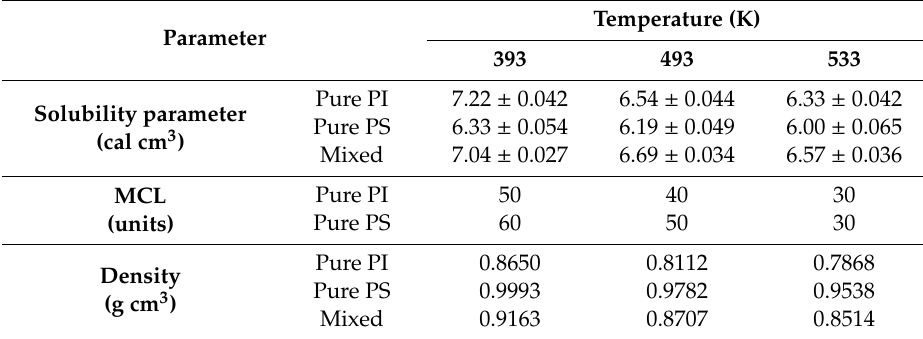
Table 1. Solubility parameter, minimum chain length of repeating unit of each polymer (MCL), and density of pure PI, pure PS and mixed systems at di ff erent temperatures.